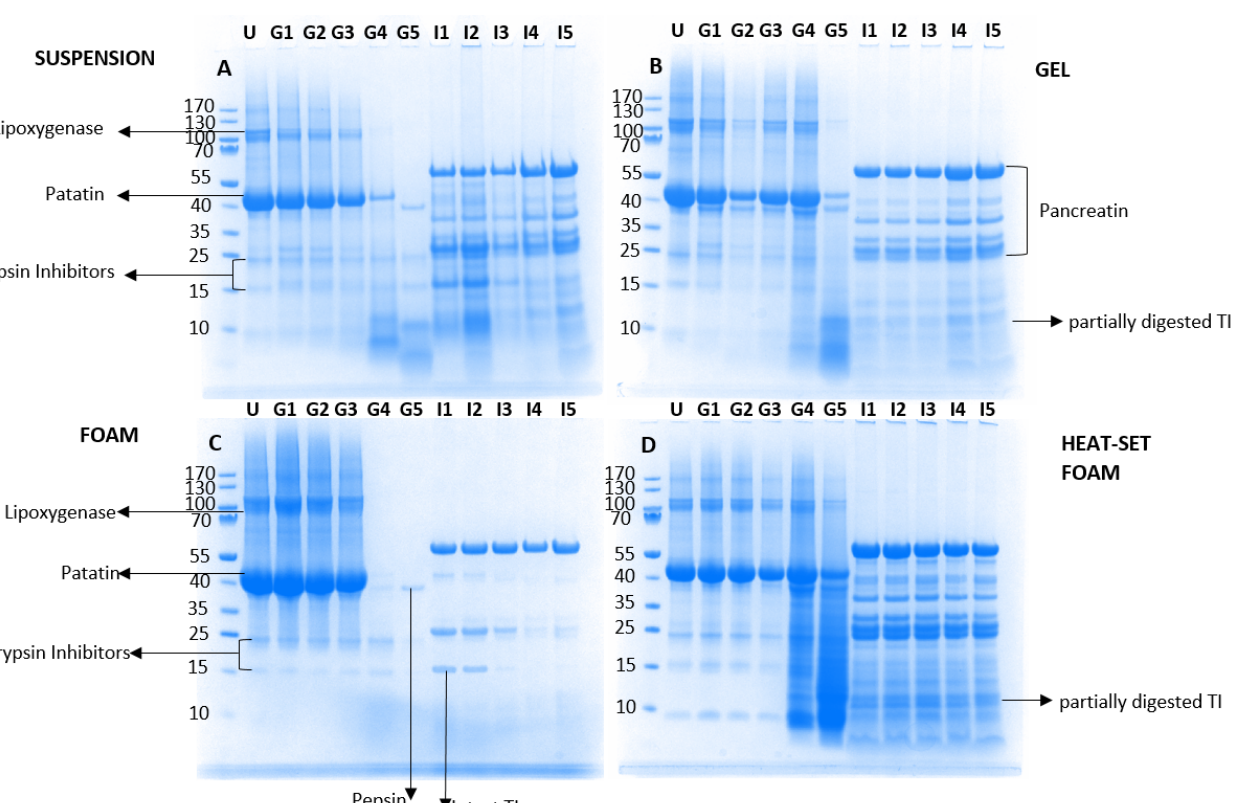
Figure 3. SDS-PAGE profiles of four different potato protein isolate matrices (4% protein, w/w) under reducing conditions: suspension ( A ), gel ( B ), foam ( C ), heat-stable foam ( D ). Undigested (U), and at the following gastric emptying points: G1 (8.26 min), G2 (16.52), G3 (24.78 min), G4 (33.04 min), G5 (41.30 min). On the right-hand side of each gel, the samples loaded are the corresponding intestinal points of each gastric point (I1–I5). Molecular weight standards are indicated on the left side, and he tmain protein fractions identified are indicated with arrows.